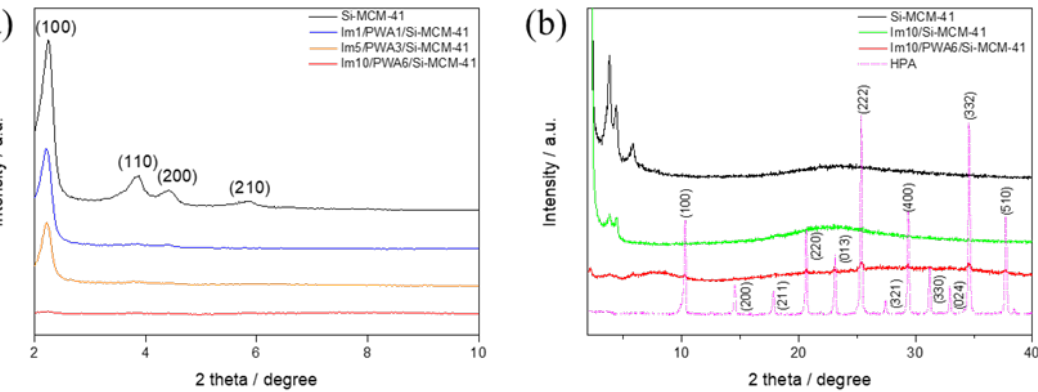
Figure 4. ( a ) XRD patterns of Im(x)/PWA(y) modified Si-MCM-41 and ( b ) XRD patterns of Im10/PWA6/Si-MCM-41.